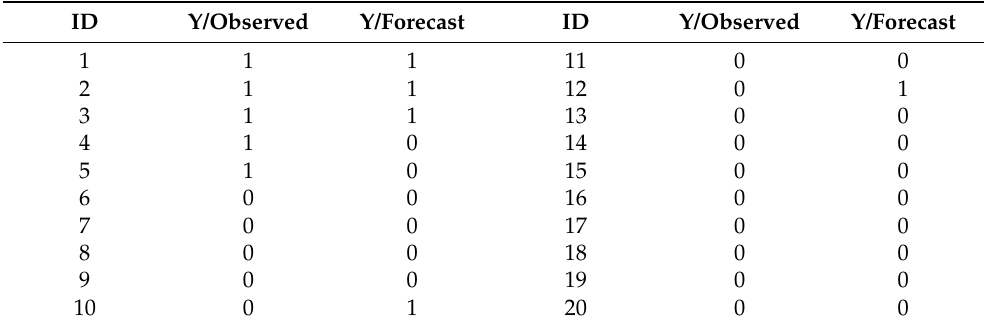
Table 3. Calculated and actual values of outburst and non-outburst samples of glacial lakes in southeast Tibet.